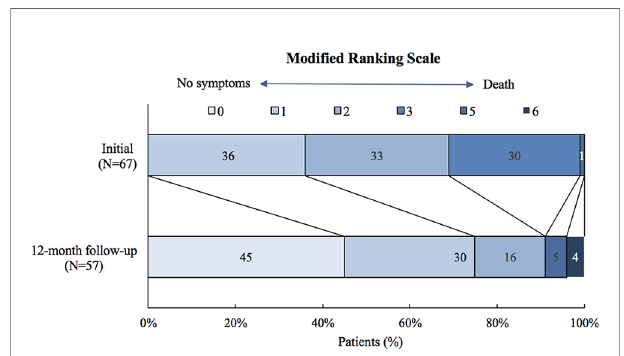
FIGURE 3 | Modi fi ed ranking scale (mRS) of patients with anti- LGI1encephalitis at the 12-month follow-up.